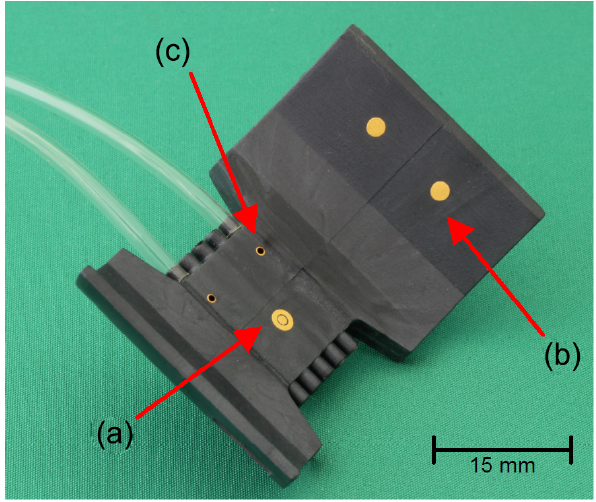
Figure 2. 3D-MID carrier for the flexible impedance spectroscopy microfluidic sensor; central sensor contact (a) , mechanical stabiliza- tion pads (b) , and fluidic contact (c) .